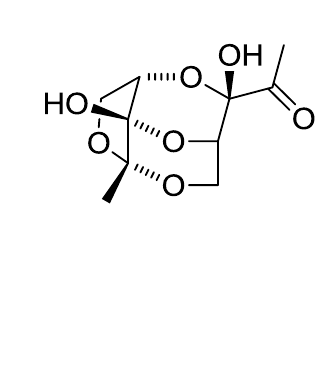
Figure 1. Structure of AI-2